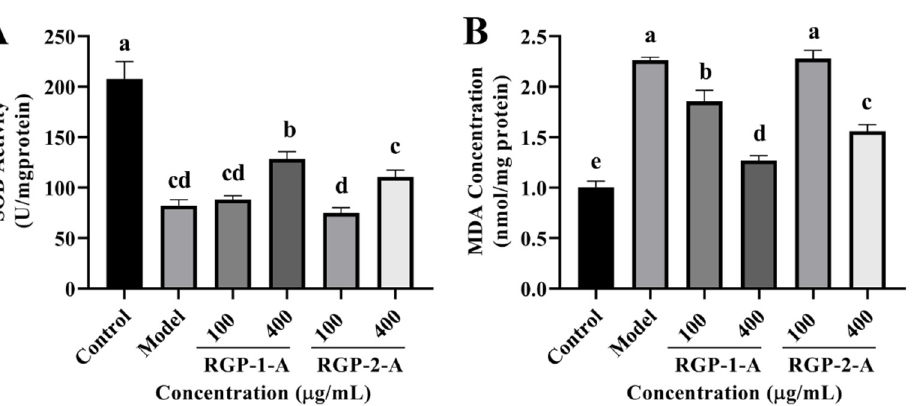
Figure 8. Effect of RGP on the antioxidant capacity of IPEC-J2 cells induced by LPS. ( A ), SOD; ( B ), MDA. RGP-1-A: decolorized pure polysaccharides of RGP obtained using AB-8 macroporous resin; RGP-2-A: decolorized pure polysaccharides of RGP obtained using H 2 O 2 . On the bar graphs, di ff er- ent lowercase le tt ers signify a signi fi cant di ff erence ( p < 0.05).